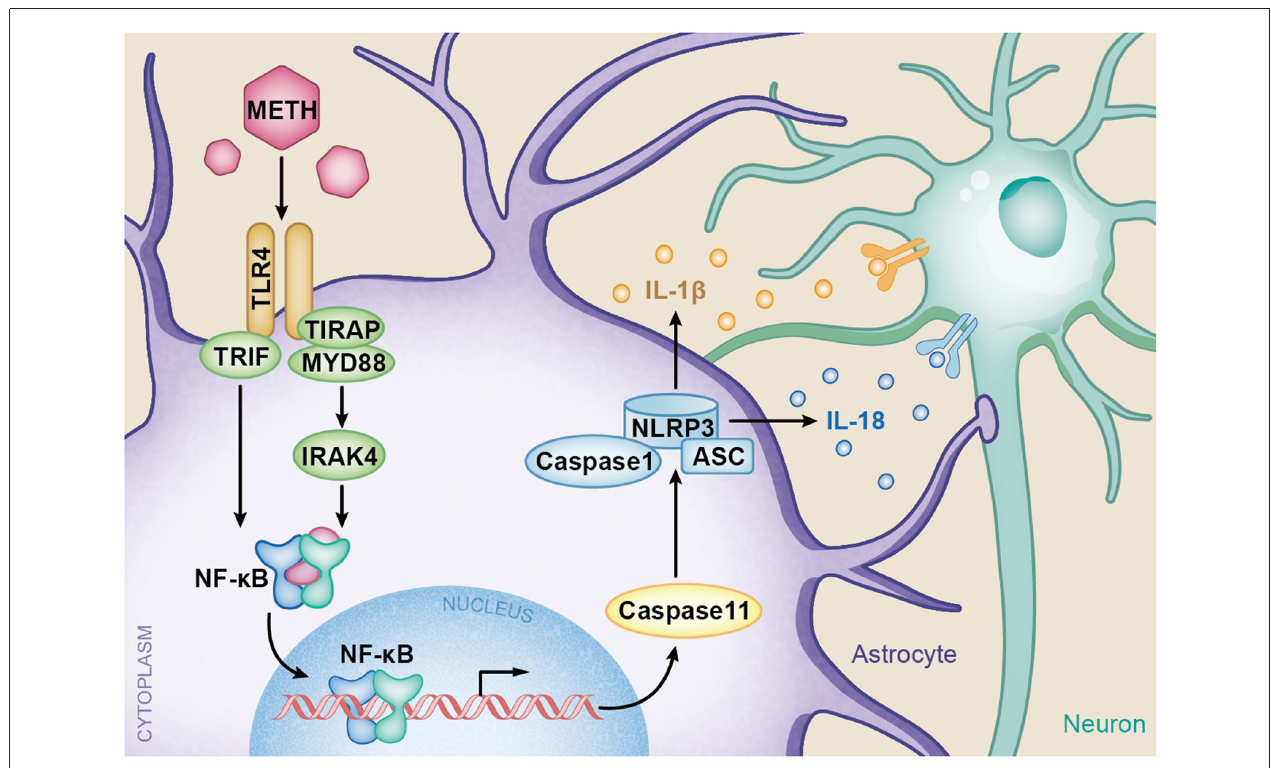
FIGURE 9 | A schematic depicting the role of TLR4-NFkB-Caspase-11 signaling pathway in METH-induced astrocyte-related neuroinflammation. Briefly, TLR4 expression is increased following METH treatment. Increased TLR4 upregulates the expression of Myd88 and TRIF. The Myd88-dependent and Myd88-independent pathways upregulate the expression of transcription factor NF- κ B. Then NF- κ B elevates Caspase-11 expression, which mediates the inflammasome NLRP3 pathway by upregulating the expression of Caspase-1 and ASC. The increased NLRP3 inflammasomes induce the expression of pro-inflammatory cytokines IL-1 β and